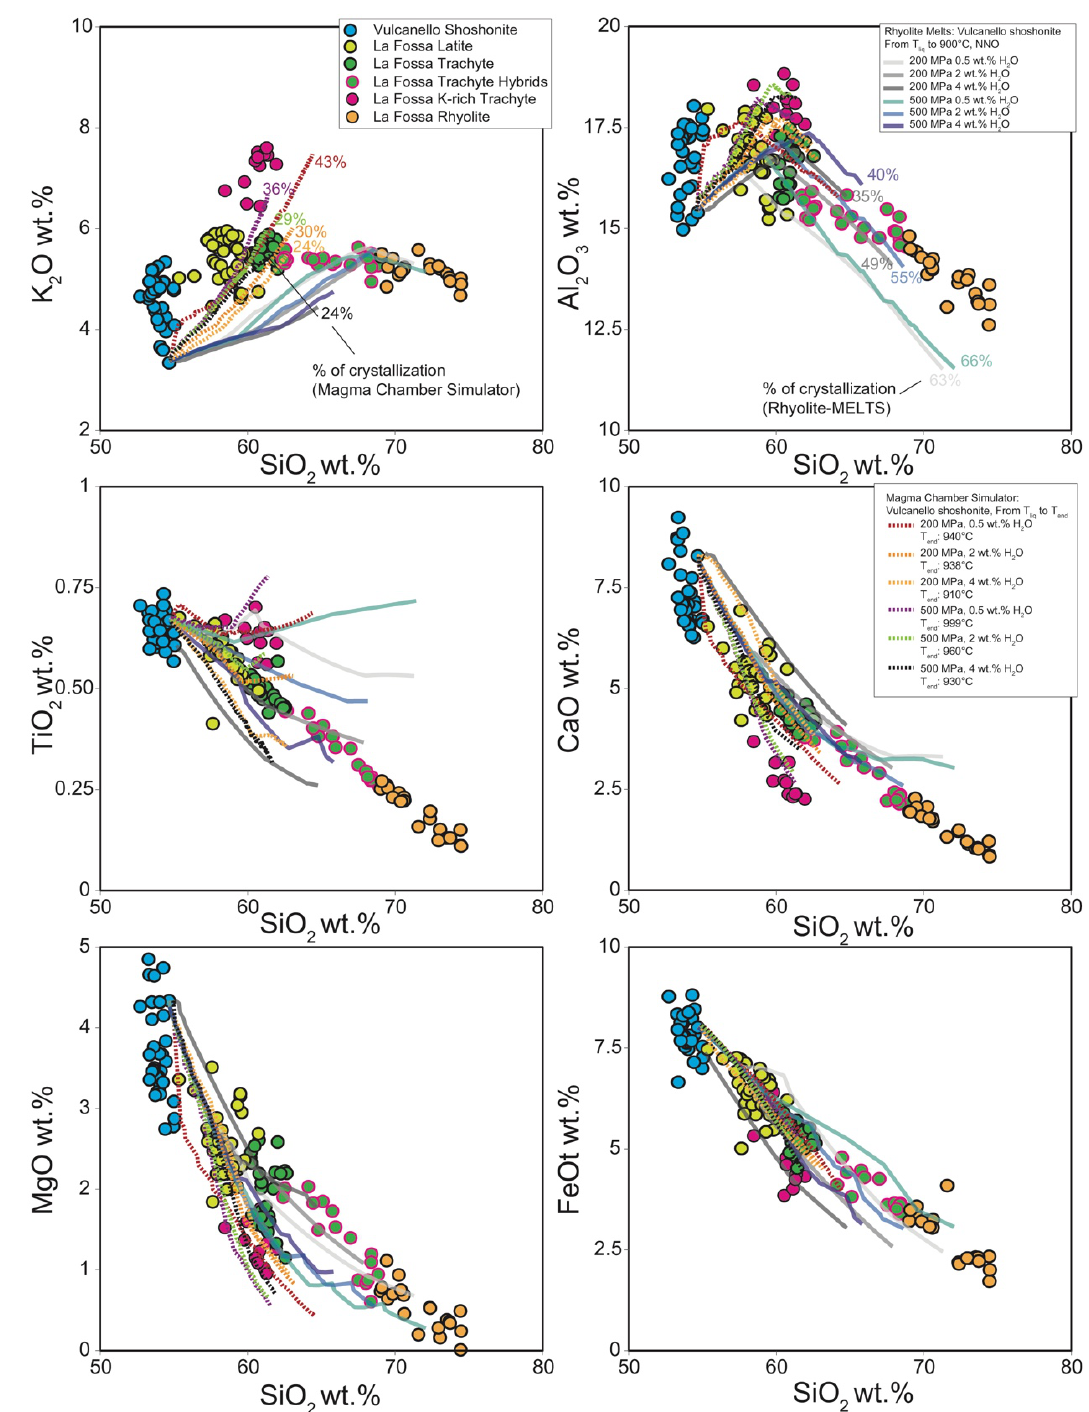
Figure 5. Liquid lines of descent resulted from assimilation and fractional crystallization of a shoshonitic magma calculated using rhyolite-MELTS and the magma chamber simulator (MCS); see the text for the parameters used in the simulations. Numbers at the end of each path refer to the amount of fractional crystallization at the ending point of 900 °C (rhyolite-MELTS) and at equilibrium temperature between magma and assimilated material (T end , MCS). Literature data sources as in Figure 2. Major elements are recalculated to 100 wt.% on anhydrous basis.